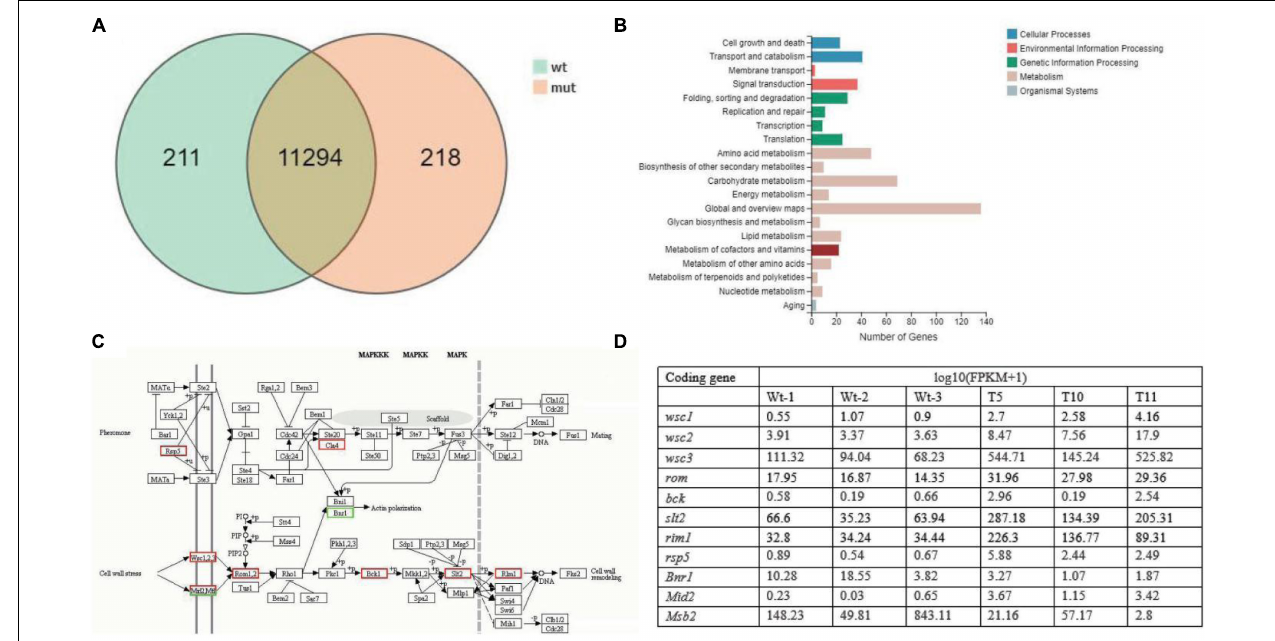
FIGURE 6 | The number of differentially expressed genes (DEGs). (A) Venn diagram depicting the number of DEGs between WT and transformant strains (mut). (B) Kyoto Encyclopedia of Genes and Genomes (KEGG) classification of the identified DEGs. (C) The putative pathway of signal transduction deduced in the KEGG analysis. (D) The expression levels of genes in the MAPK